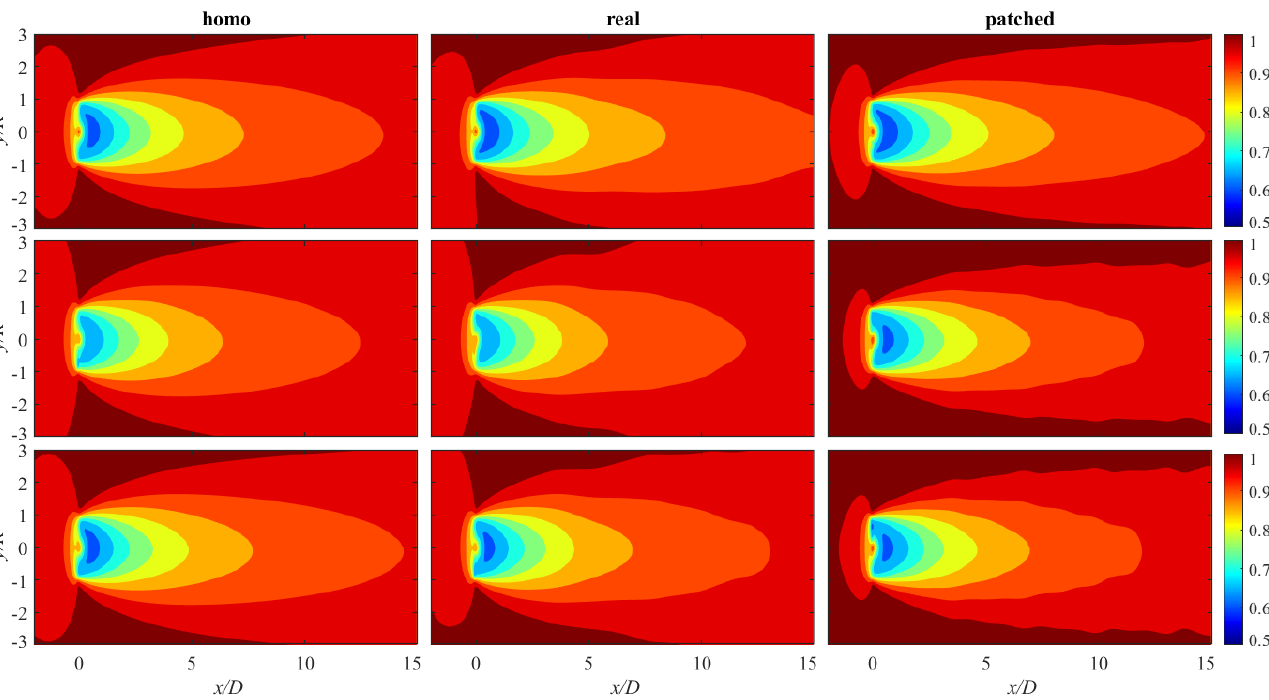
Figure 23. Mean velocity contours from horizontal (X-Y) planes at the hub height. Row-wise, LAI =